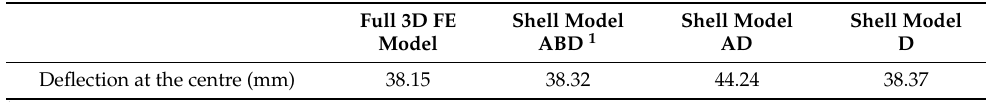
Figure 14. Comparison of vertical deflections: ( a ) RVE-2 shell model ABD; ( b ) full 3D FE model (Type-EQ). Table 6. The deflection at the mid-span computed using the full 3D (Type-EQ) model and three simplified shell models (based on RVE-2 homogenization FE